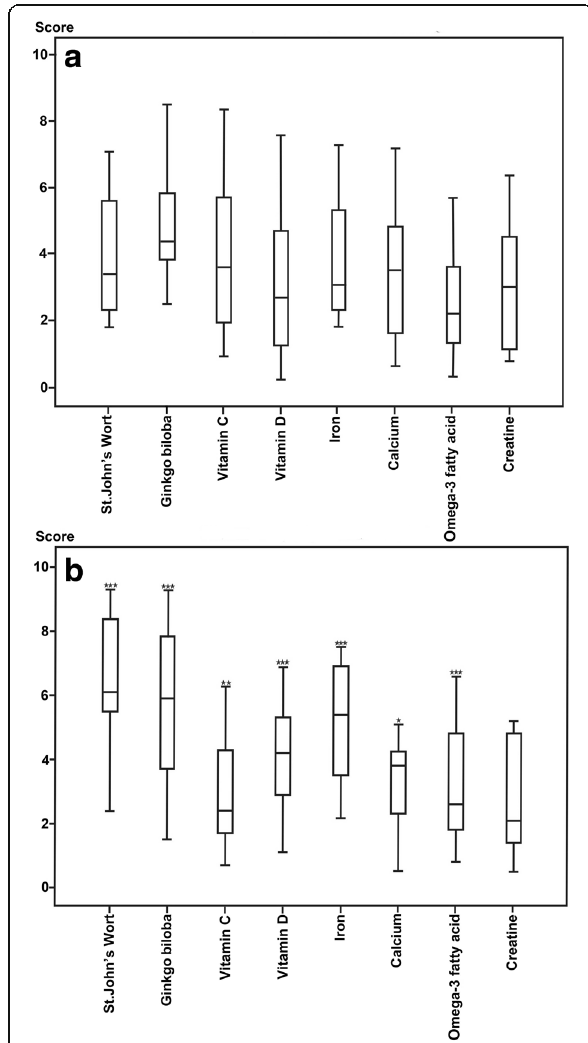
Fig. 1 Perceived risk of adverse reactions to DS. Results are presented as median scores of perceived risk on visual analogue scales (25th – 75th centiles) by the ( a ) medical students not educated and ( b ) educated in pharmacology. * p < 0.05, ** p < 0.01, and *** p < 0.001 for differences between MSNEP and